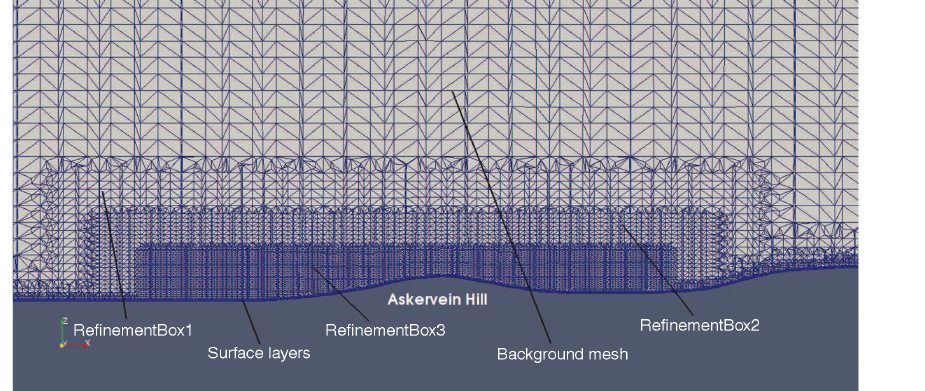
Figure 3. Askervein Hill: cross section of the grid created by SnappyHexMesh. Three refinement boxes together with variations in number of surface layers indicated in the figure are used as a basis for generation of the grids described in Table